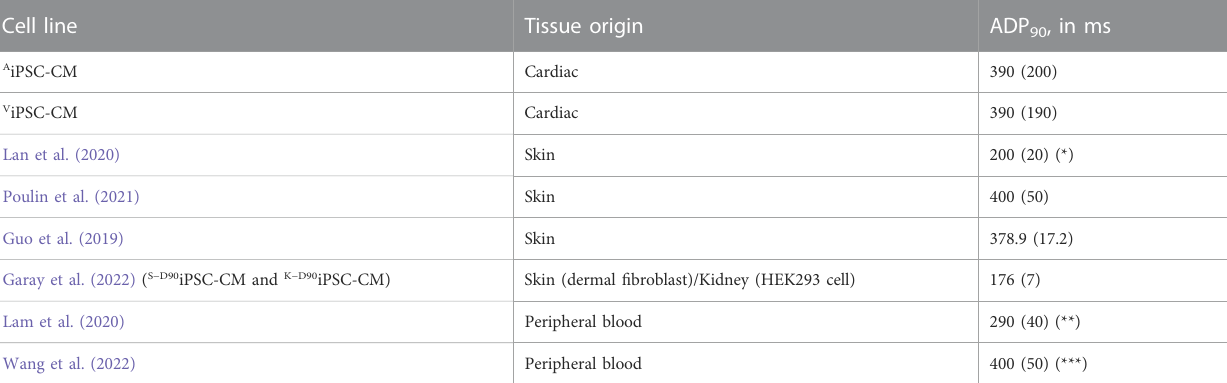
TABLE 2 Comparison of conduction velocity (in cm/s) between A iPSC-CM/ V iPSC-CM and other reported iPSC-CM derived from skin, kidney, and peripheral blood tissues. The numbers were written in mean (standard deviation) format. Cell